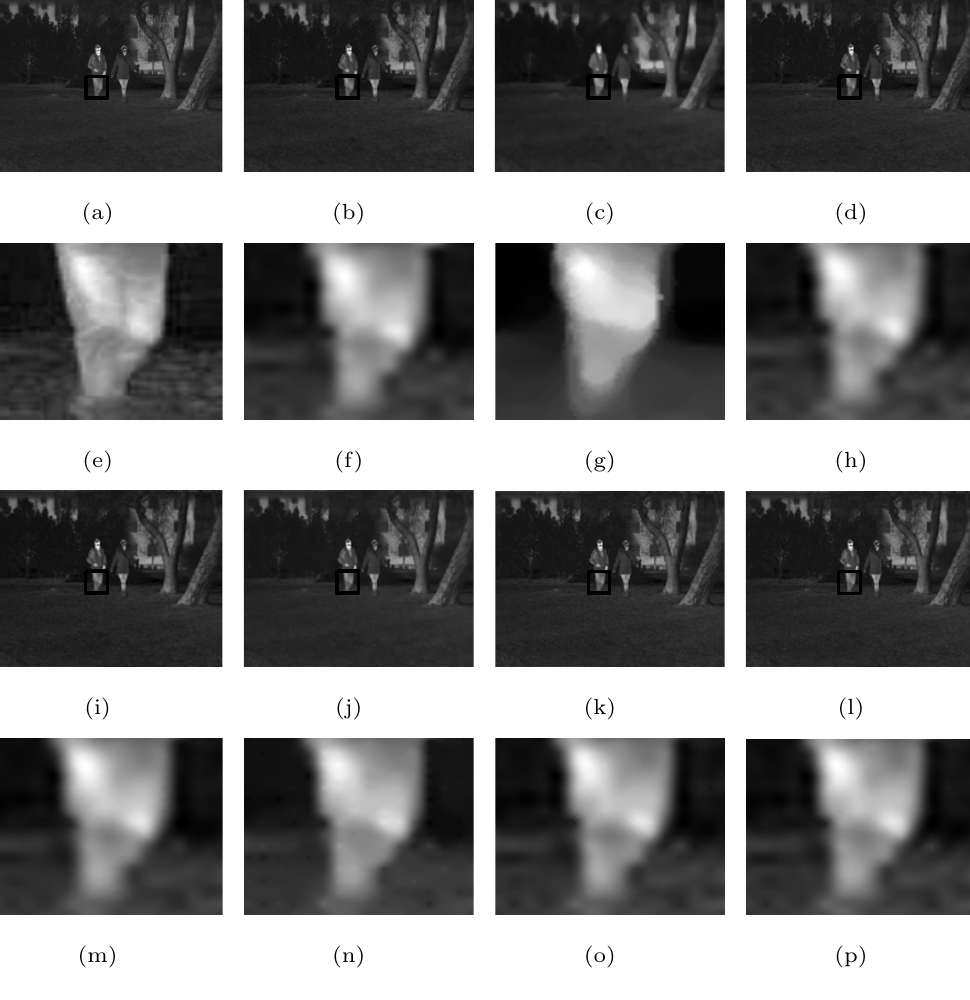
(a) 图 1: description of figure